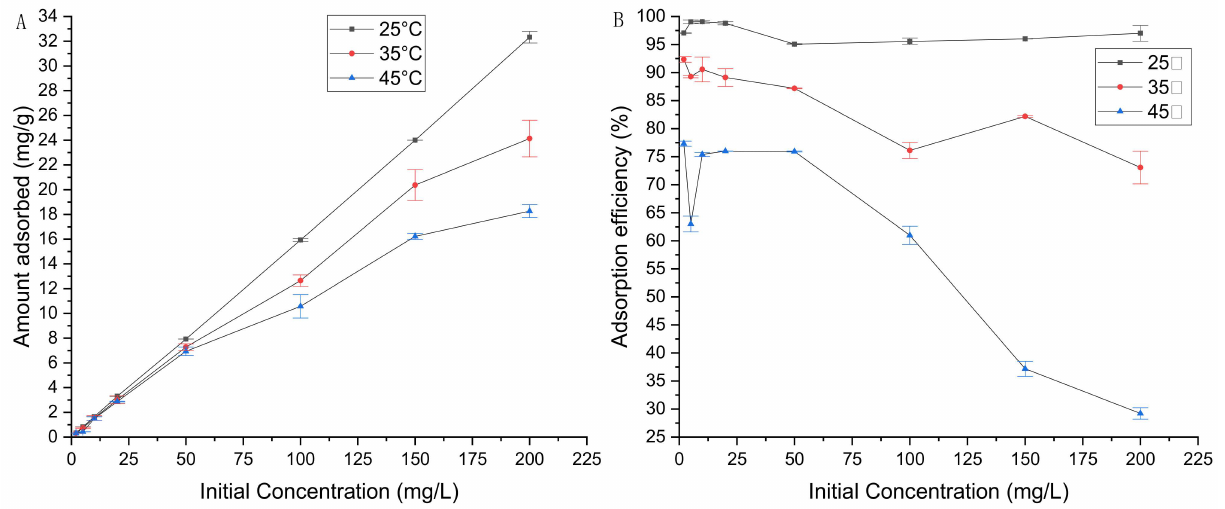
Figure 4. Three temperature gradients were measured to determine the amount adsorbed ( A ) and adsorption efficiency ( B ) of Al 13 -O-MMt in different initial concentrations of